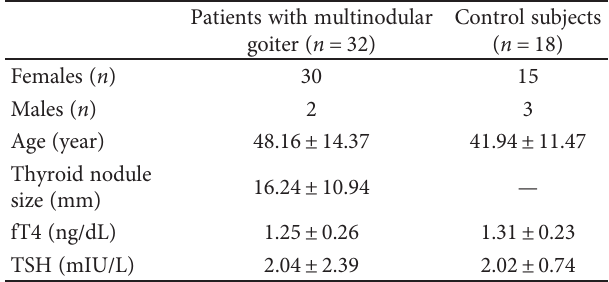
Table 1: Characteristics of patients with multinodular goiter and control subjects (mean ±